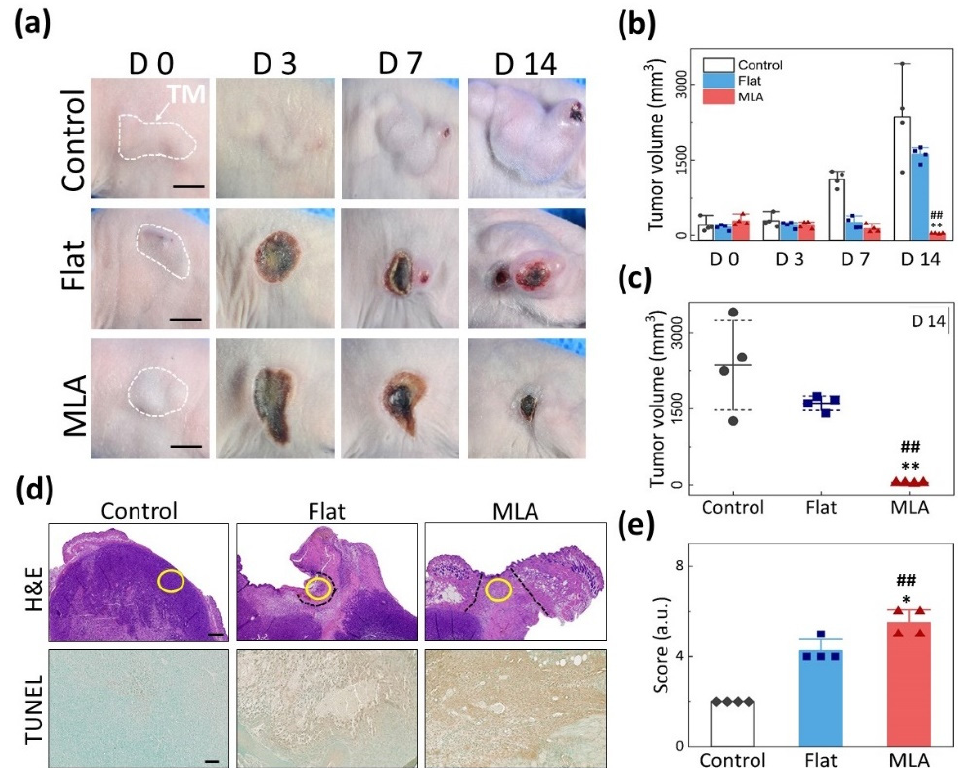
Figure 5. In vivo photothermal treatment of CT26 tumor-bearing mouse models with Flat-based and MLA-assisted irradiations at 2 W/cm 2 for 180 s (dye concentration = 300 µ g/mL in PBS): ( a ) compilation of images of tumor model at various time points after laser irradiation (TM = tumor region; scale bar = 5 mm), ( b ) comparison of tumor growth after laser treatment, ( c ) statistical comparison of tumor volumes at D 14, ( d ) HE-stained (top row; 20 × scale bar = 600 µ m) and TUNEL- stained (bottom row; 100 × scale bar = 50 µ m) images of treated tumor cross-sections at D 14, and ( e ) semi-quantitative evaluations of histopathological responses from treated tumor tissue. Note that black dashed and yellow solid lines in (d) represent the laser-treated area and the observed area for TUNEL analysis, respectively ( n = 4 per group; KW p < 0.01; ## MU p < 0.005 vs. control; ** MU p < 0.005 and * MU p < 0.05 vs. Flat).